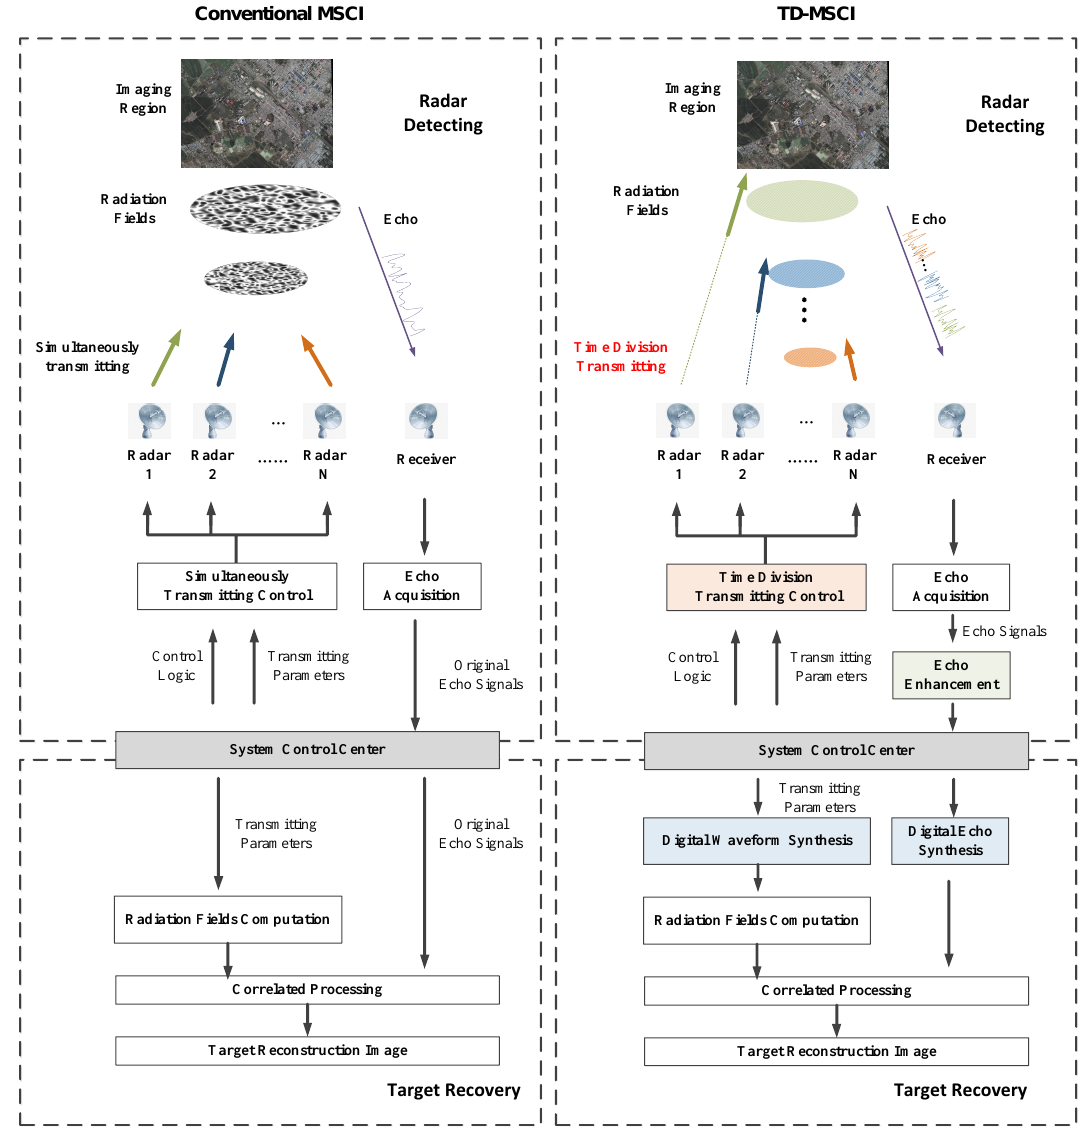
Figure 4. Procedures of the proposed Time-Division MSCI (TD-MSCI), compared with conventional simultaneously transmitting based